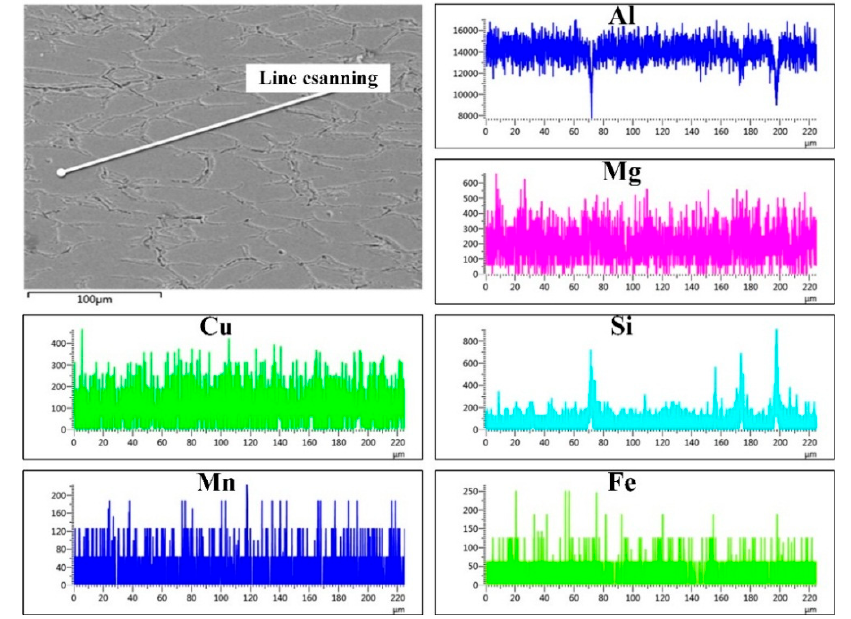
Figure 7. The distribution of different alloying elements in the segregation free region.